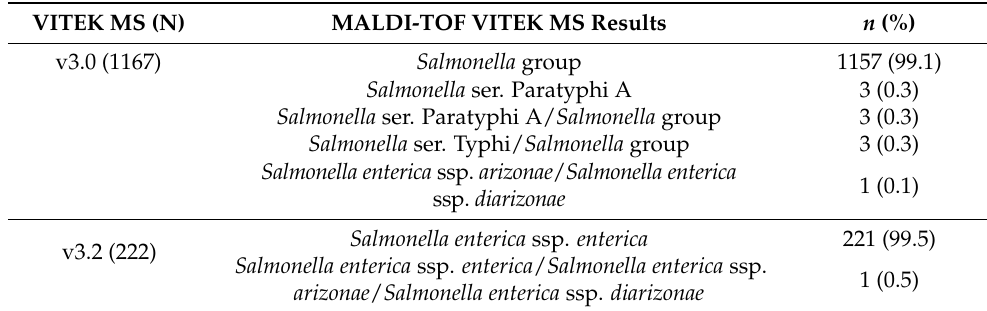
Table 3. Salmonella identification results by VITEK MS v3.0 and